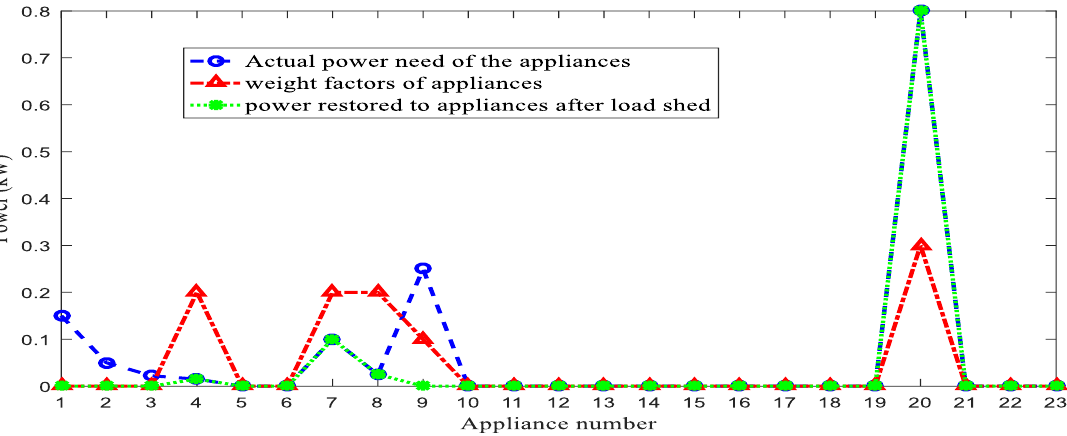
Figure 13. Actual load to meet, weight factors assigned for priority of appliance, and power restored due to EVs for residential user 7.